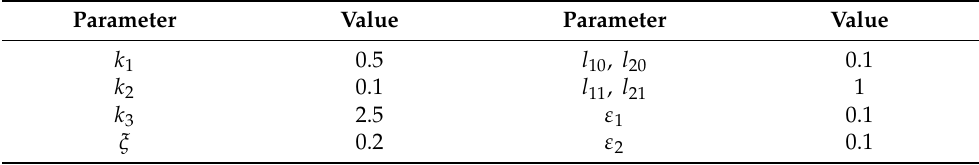
Table 1. The parameters of sliding mode manifold and barrier function-based super-twisting controller. Parameter Value